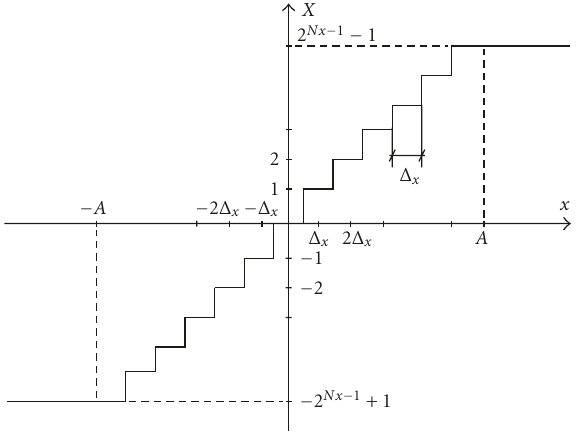
Figure 9: Staircase conversion function from floating- to fixed- point